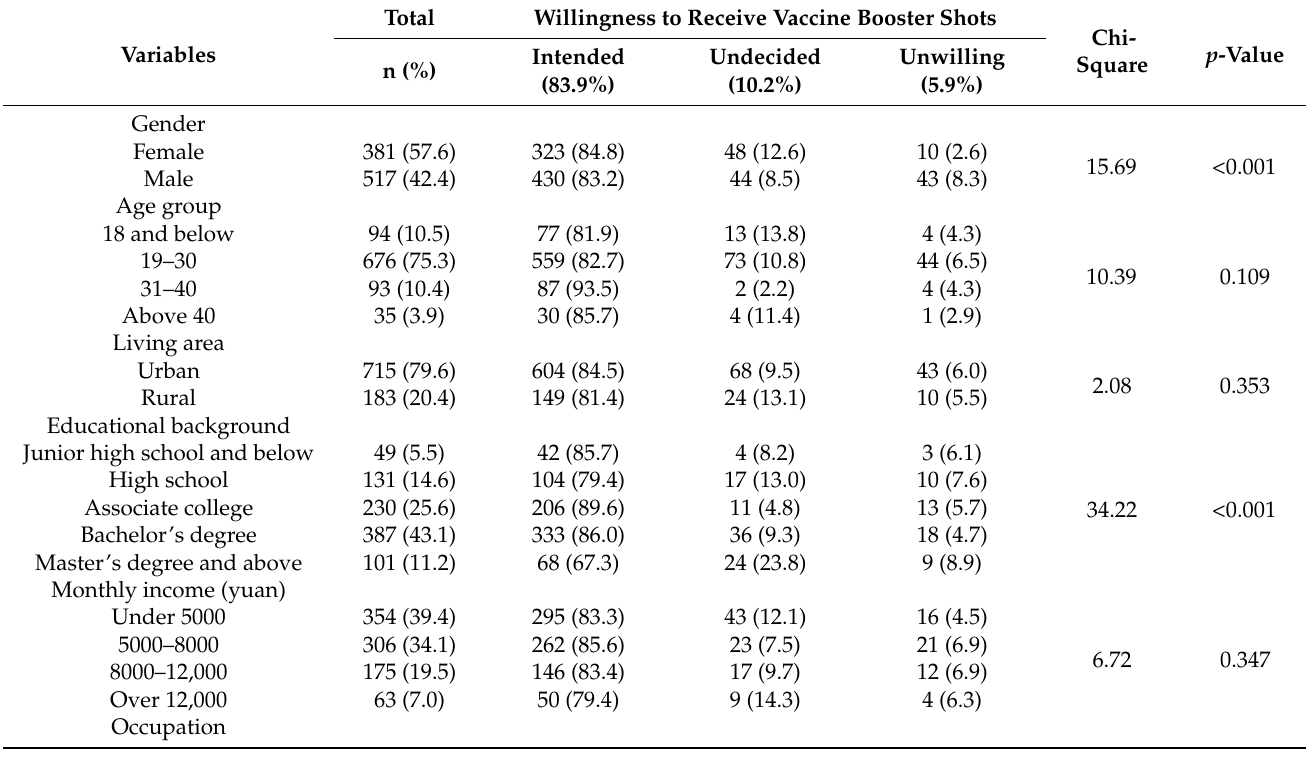
Table 1. Sociodemographic characteristics of the sample (n =